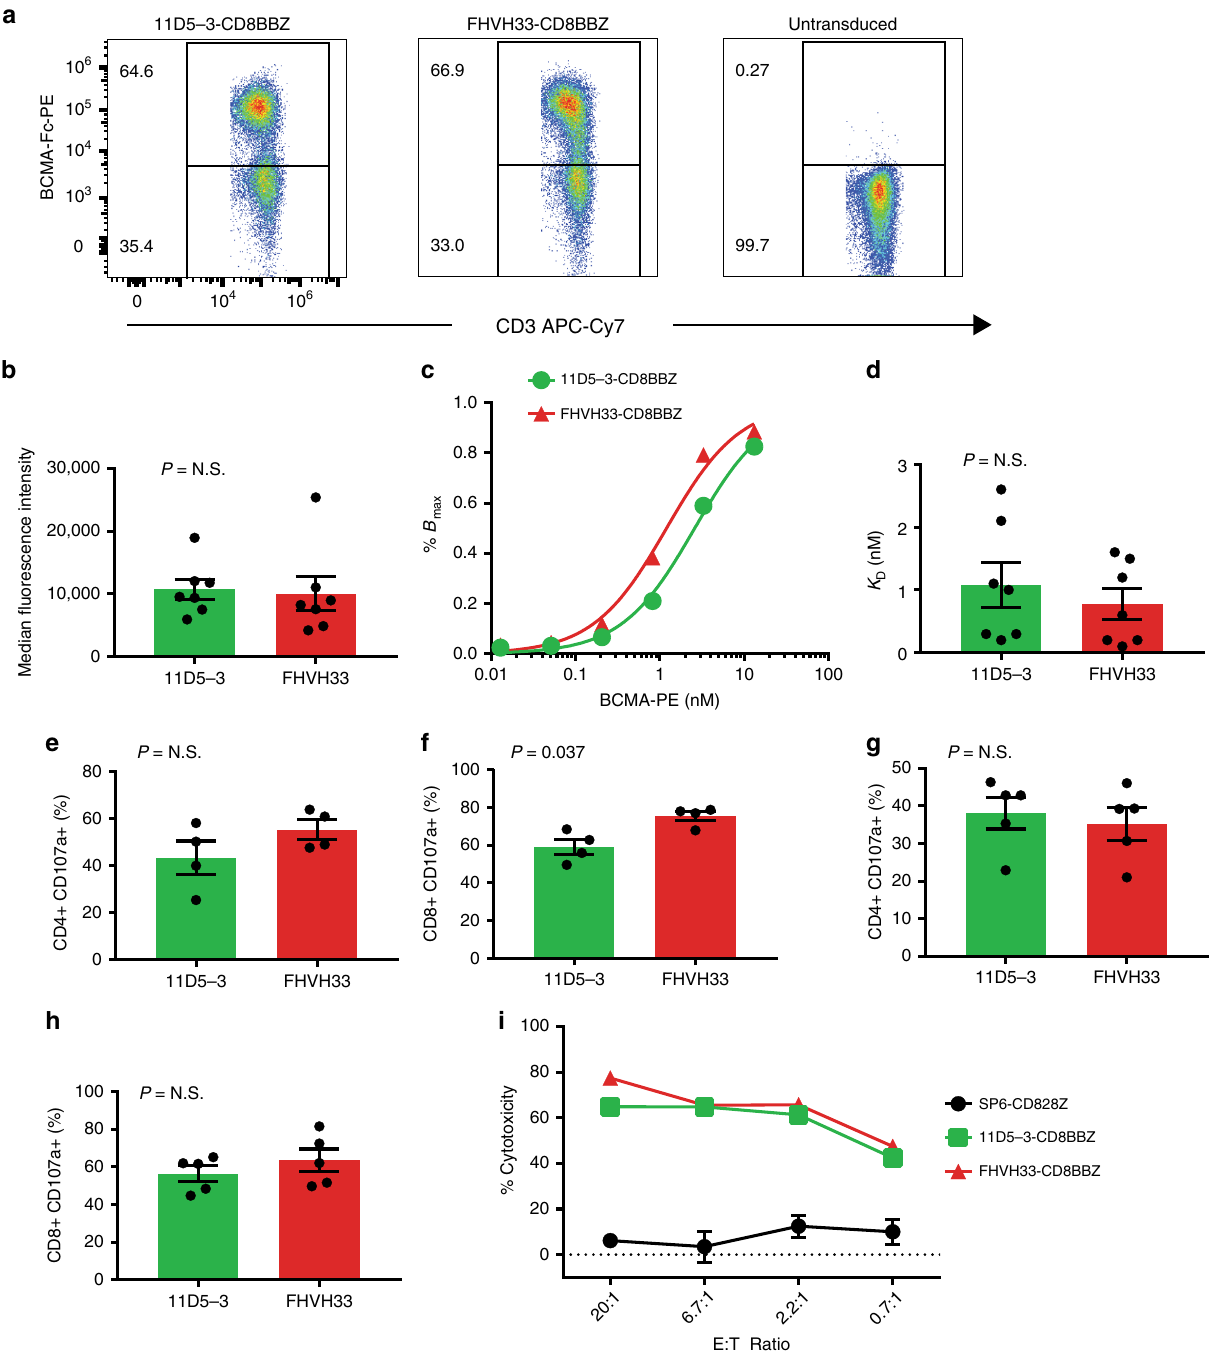
Fig. 2 Murine scFv 11D5-3 versus fully human heavy-chain domain FHVH33. a Flow cytometry results of T cells from the same donor transduced